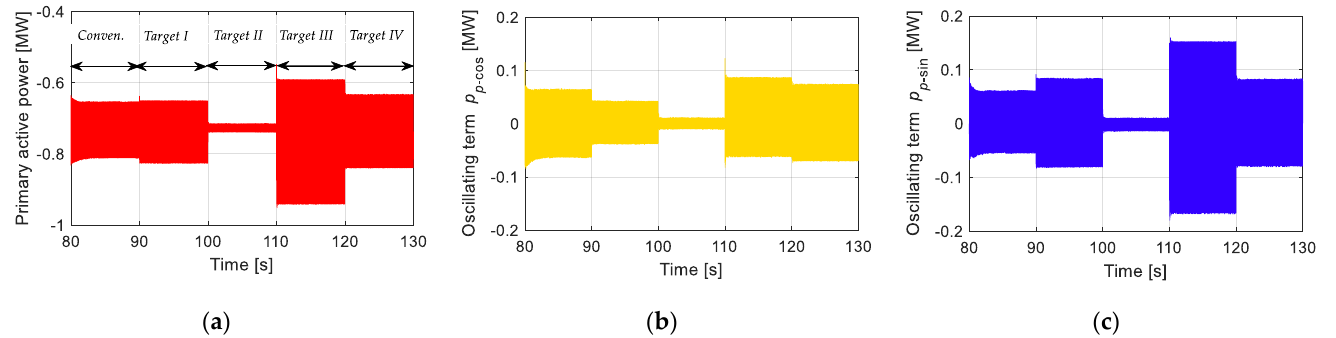
Figure 14. Simulated results with different control targets: 90 – 100 s: Target I ; 100 – 110 s: Target II ; 110 – 120 s: Target III ; 120 – 130 s: Target IV ; ( a ) Primary active power; ( b ) Oscillating term ( p p _cos ); ( c ) Oscillating term ( p p _sin ).